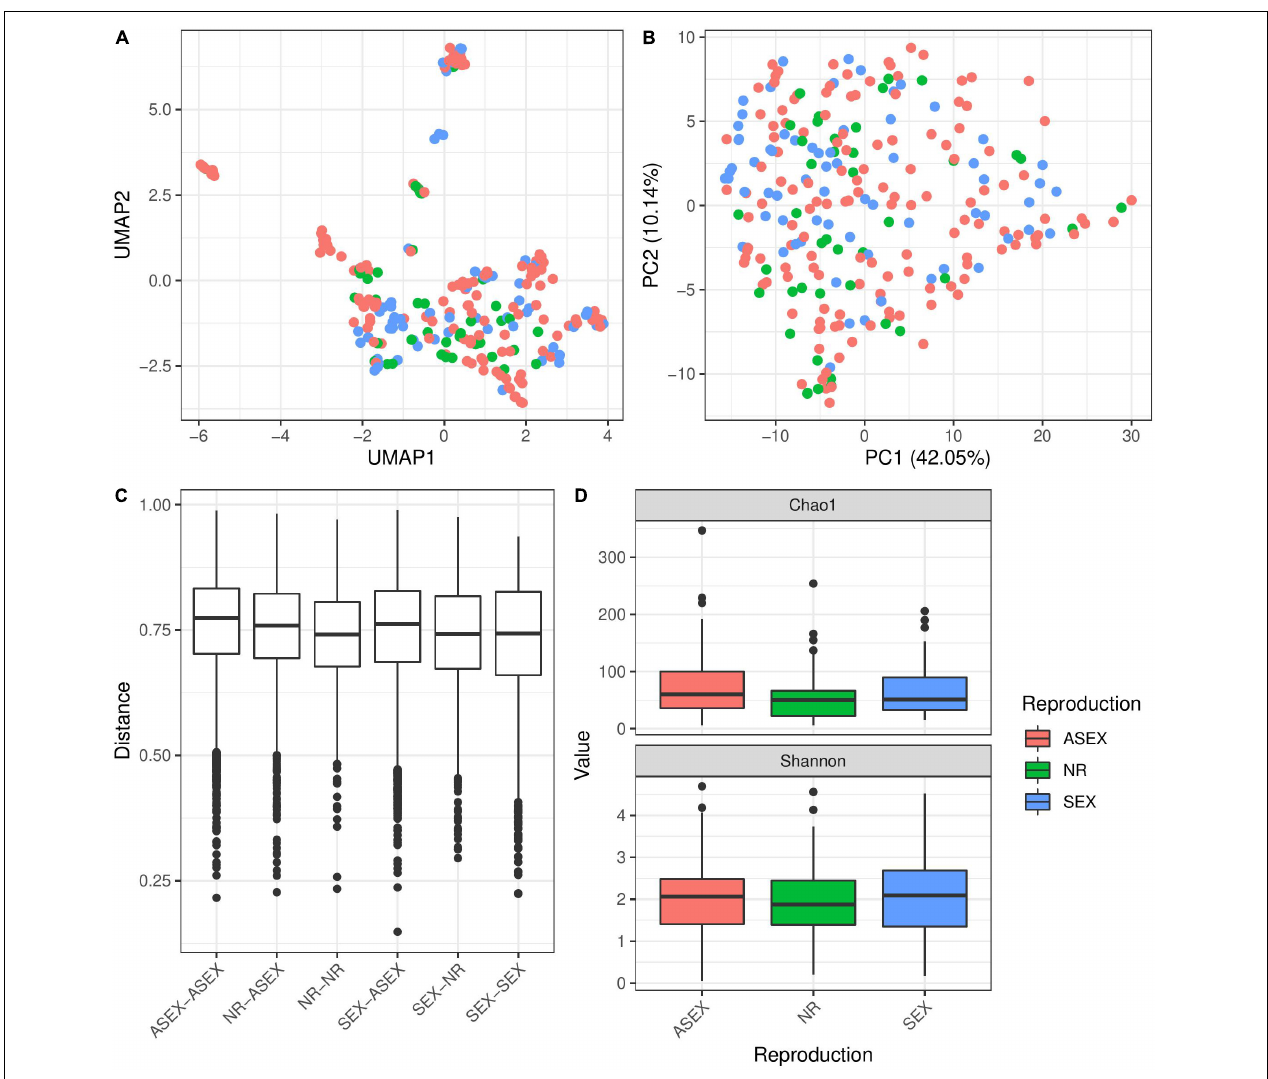
FIGURE 6 | The influence of reproduction mode on microbial diversity in Hydra . UMAP (A) and PCA (B) ordination plots for the Bray–Curtis dissimilarity show no clustering of samples by reproduction mode. However, univariate PERMANOVA retrieved a significant effect of reproduction mode on β -diversity ( R 2 = 0.01, p = 0.0012, 999 permutations, Table 2 ). However, multivariate PERMANOVA results do not support a statistical effect in differences due to the mode of reproduction in Bray–Curtis dissimilarity ( R 2 = 0.01, p = 0.2848, 999 permutations, Table 2 ). Similarly, the boxplot for Bray–Curtis dissimilarity (C) shows no major difference between the different pairs of reproduction modes. However, α -diversity (D) is affected by the reproduction mode in a multivariate linear mixed model ( p = 0.007, Table 3 ), an effect which is not supported by univariate linear models ( p = 0.842, Table 3